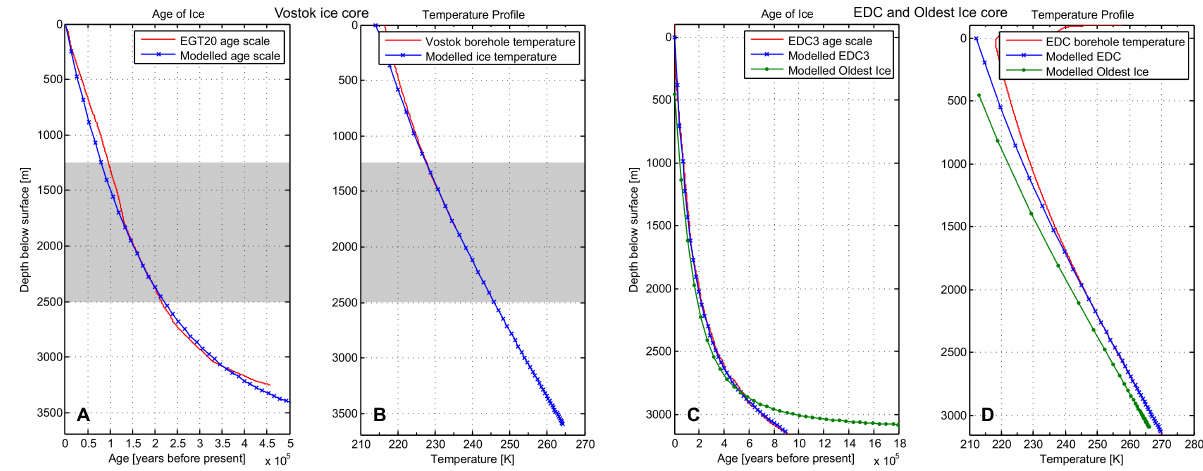
Fig. 1. Age of ice (A, C) and ice temperature (B, D) profiles of the Vostok (A, B) as well as of the EDC and oldest ice core (C, D) . Red lines: reference records for tuning the ice parameters ( A EGT20 age scale (Petit et al., 1999); EDC3 age scale (Parrenin et al., 2007a); (B) Vostok bore hole temperature (Salamatin et al., 1994); (D) EDC bore hole temperature measured in December 2004). Blue lines: modelled ice age and ice temperature profiles using the Vostok (A, B) and EDC (C, D) ice parameters (Table 1). Green lines: modelled ice age and ice temperature profiles using the oldest ice core ice parameters. The grey shaded area marks the depth below the BCTZ for which the simulations of Sect. 3 have been performed. The depth level zero corresponds to the model ice sheet thickness at Vostok (A, B) and EDC (C, D) drill site inm ice equivalent. The depth of the oldest ice core is shifted by 453m such that the bedrock is reached at the same depth as for the EDC